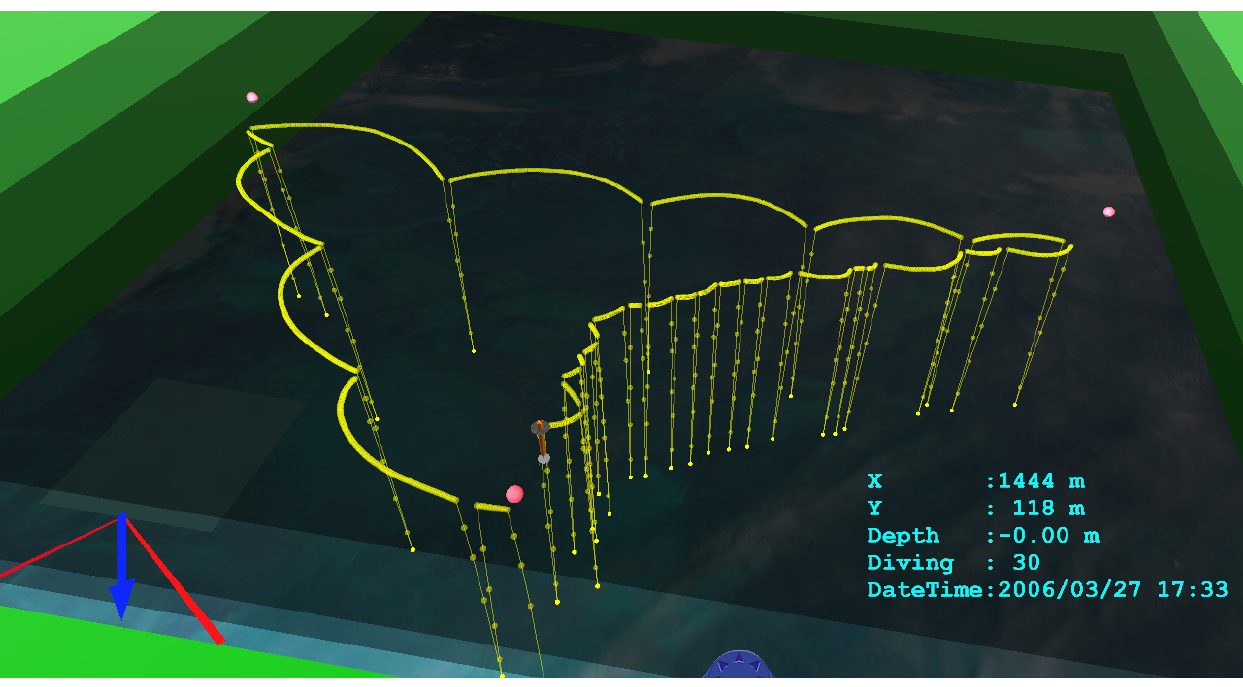
Figure 8: Trajectory of the profiler (clamp mechanism) in a 3-D virtual